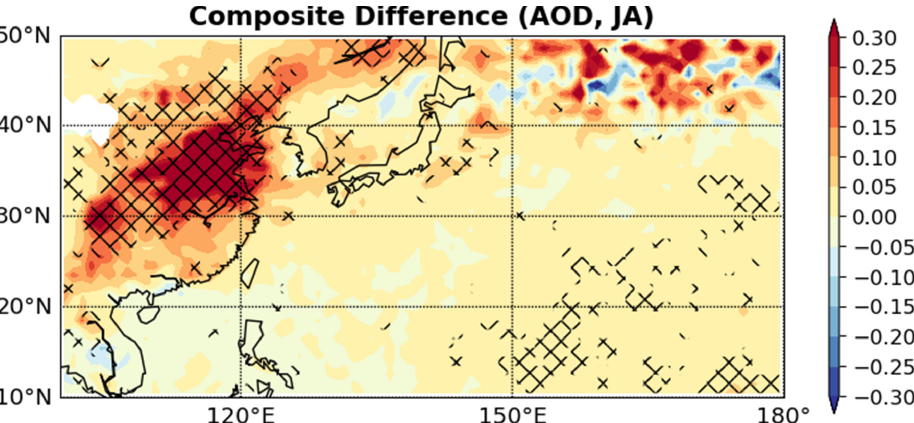
Figure 5. The composite difference of AOD during JA (high AOD minus low AOD). Regions with black cross-hatching indicate a statistical significance at a 95% confidence level.